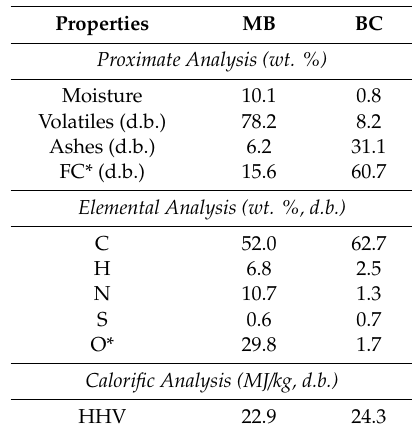
Table 2. Proximate analysis, elemental analysis, and calorific values for the microalgae biomass (MB) and the bituminous coal (BC) used in this